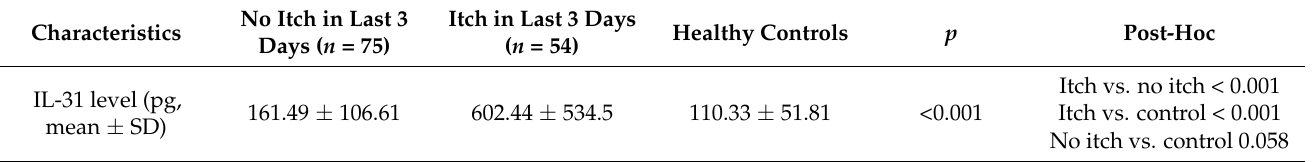
Table 2. Differences in IL-31 concentrations between studied